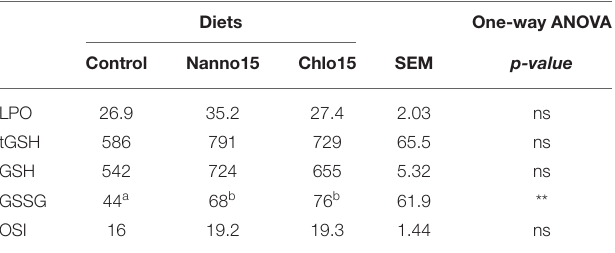
Values presented as means (n = 12) and pooled standard error of the mean (SEM). Different letters in the same row stand for statistical differences between diets (p ≤ 0.05). ns, non-significant (p > 0.05); ** p ≤